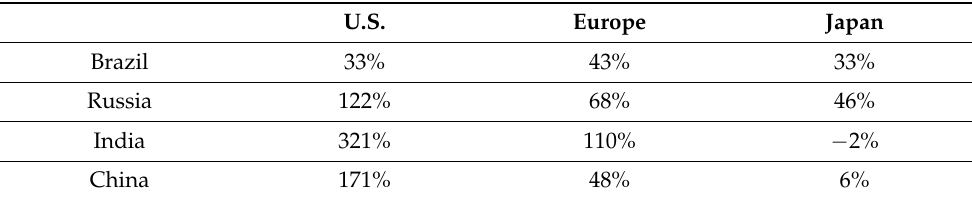
Table 4. Percentage Change in Unconditional Correlation between BRIC and Advanced Economies Pre July 2008 and Post June